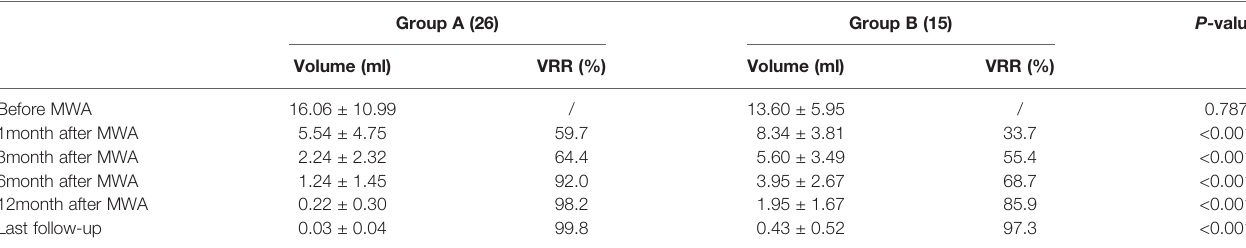
TABLE 4 | Comparison of MWA curative effect between two groups.